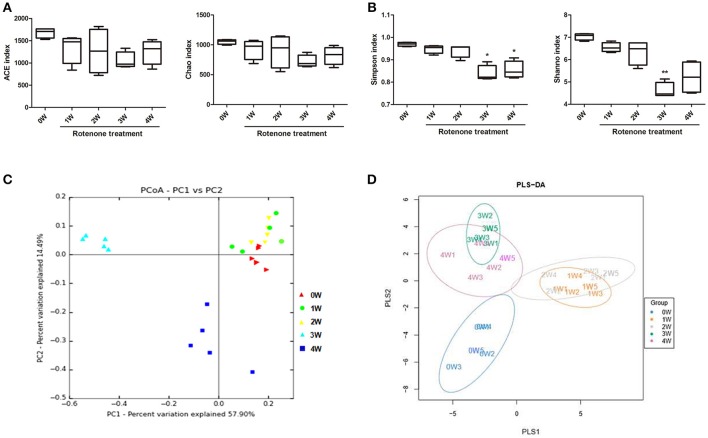
Variation in fecal bacterial α-diversity and β-diversity over time. (A) ACE and Chao indexes. (B) Simpson’s and Shannon’s diversity indexes (C) PCoA analysis based on weighted Unifrac distance. (D) Score plots of PLS-DA among the microbial community data in rotenone-treated mice. *p < 0.05, **p < 0.01 vs. 0W.